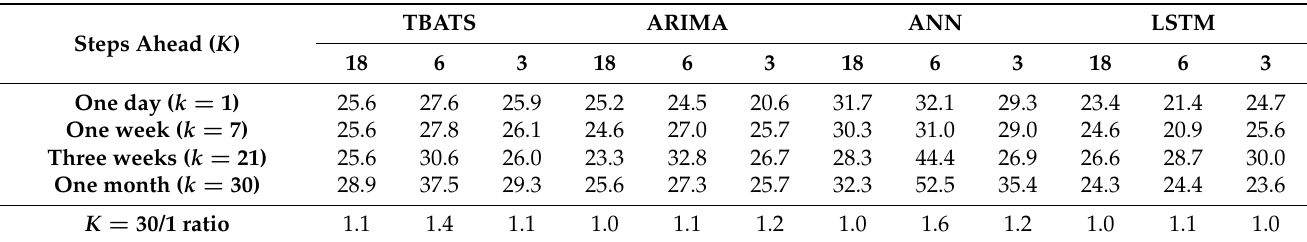
Table 10. Accuracy of rolling forecasting with different historical lengths (3, 6, and 18 months) at the single charging station scale. Steps Ahead ( K )